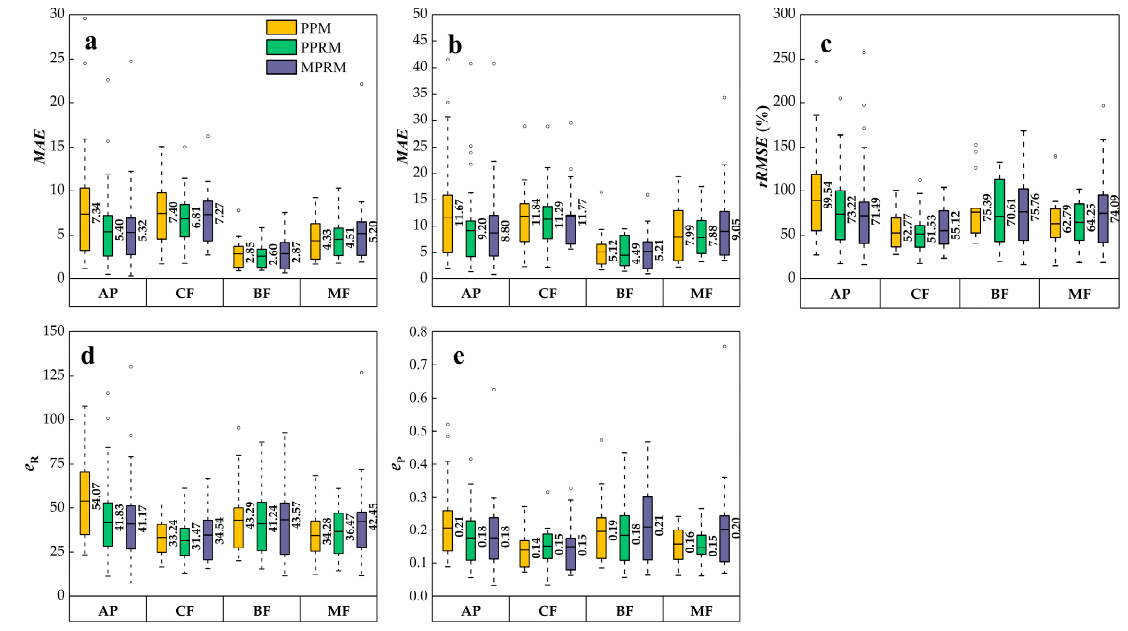
Figure 6. The box plots for the comparison of reference and predicted individual tree volume distributions in different Weibull parameter predictive models (PPM, PPRM, and MPRM) using LiDAR-predicted stem density N LiDAR as the scaling variable. The goodness-of-fit for predicted volume distributions was evaluated by MAE ( a ), RMSE ( b ), rRMSE ( c ), e R ( d ), e P ( e ). The number beside each box represents the mean value of the relative statistics. PPM: parameter prediction method; PPRM: percentile-based parameter recovery method; MPRM: moment-based parameter recovery method; AP: all plots; CF: coniferous forest plots; BF: broadleaved forest plots; MF: mixed forest